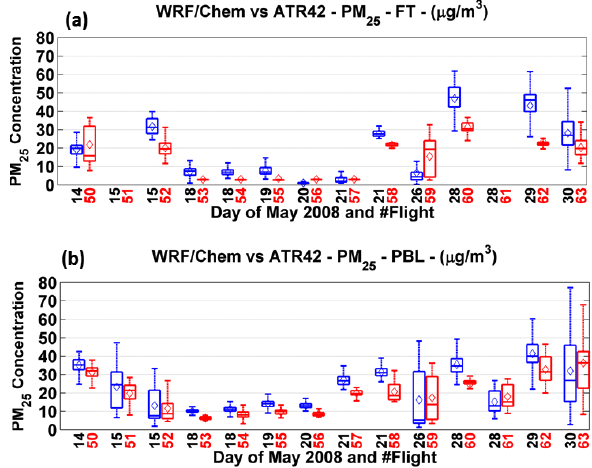
Figure 7. Same as Fig. 6 but for observed and simulated PM 2 . 5 mass concentrations. The blue colour represents the observations, while the model is displayed in red